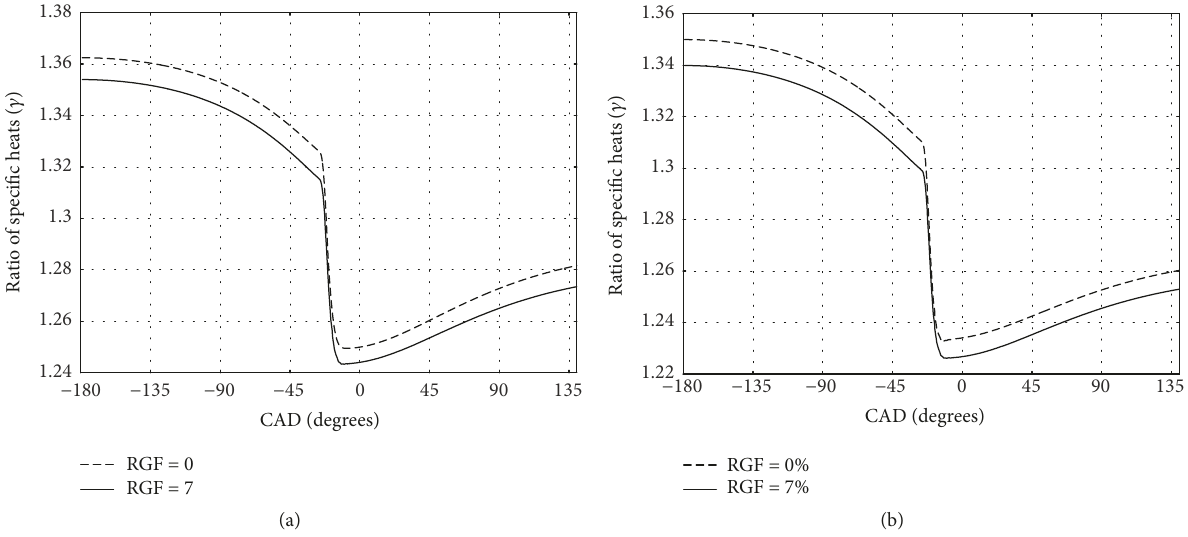
Figure 12: Temporal variation of ratio of specific heats: (a) lean mixture and (b) rich